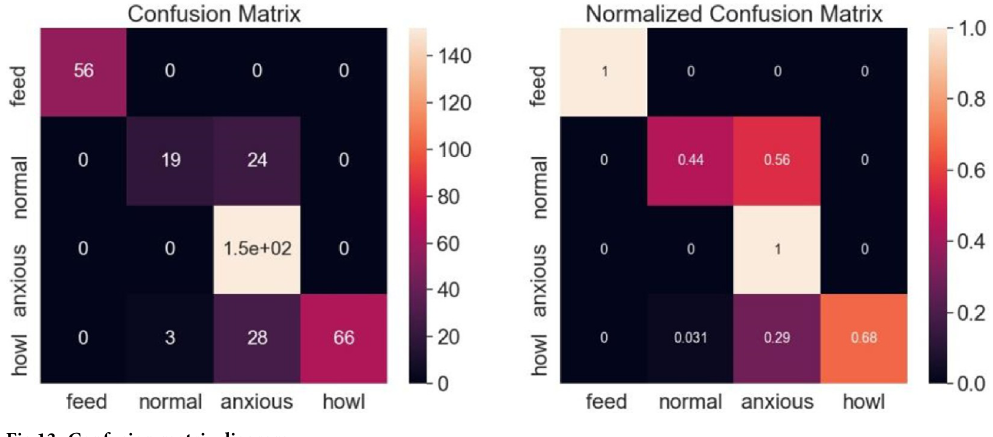
Fig 13. Confusion matrix